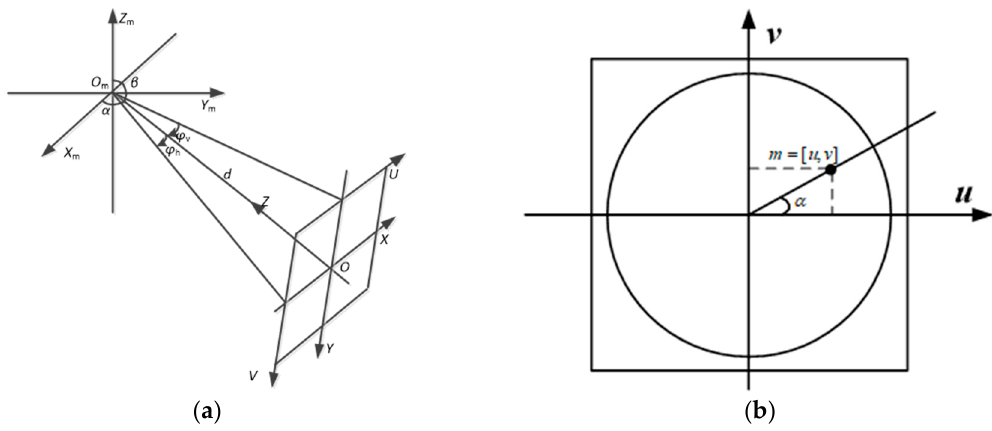
Figure 4. ( a ) The effective viewpoint of the virtual perspective image; ( b ) the coordinate of the omnidirectional image.